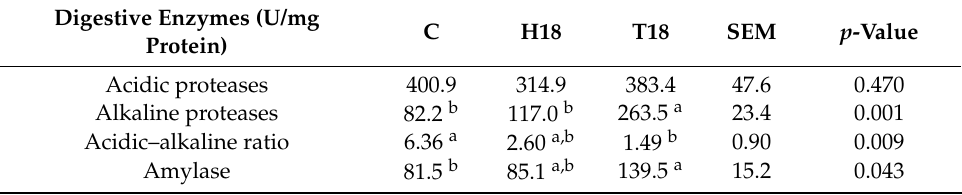
Table 4. Digestive enzymes of rainbow trout fed experimental diets. Digestive Enzymes (U/mg Protein)